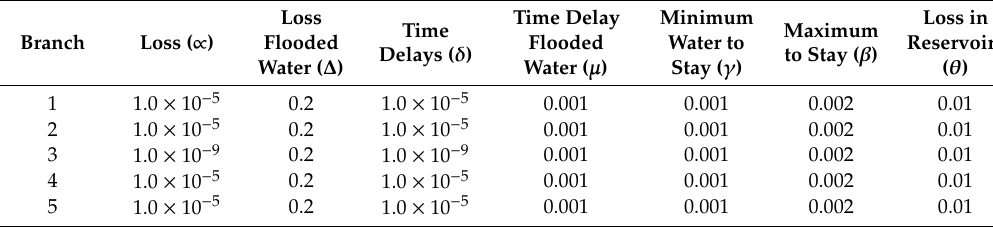
Table 5. Parameters per segment during the final iteration.